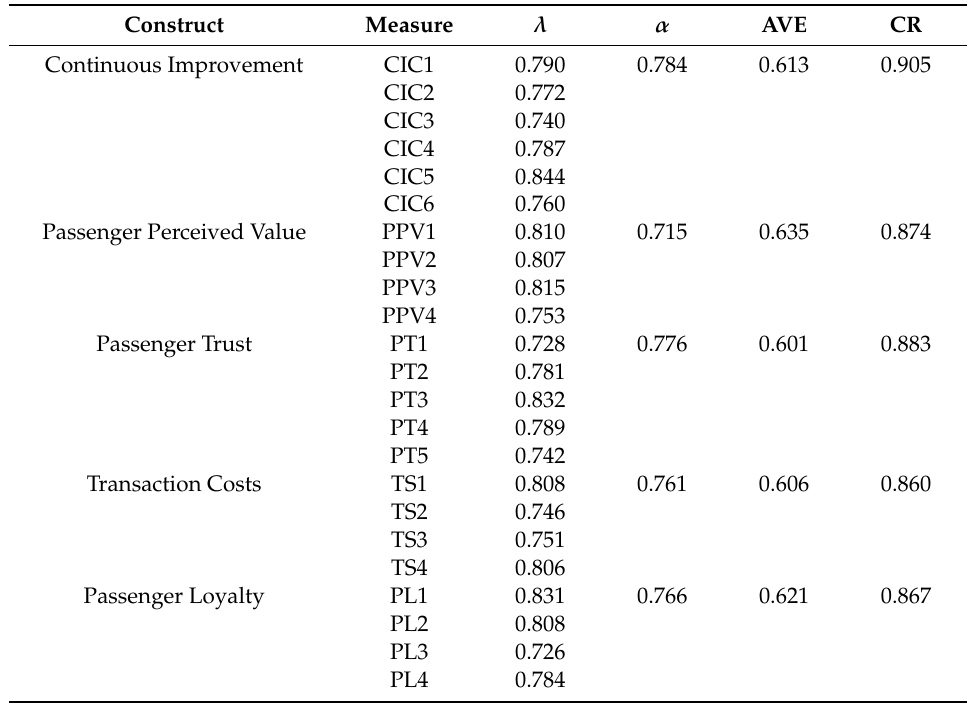
Table 3. Validity and reliability analysis.